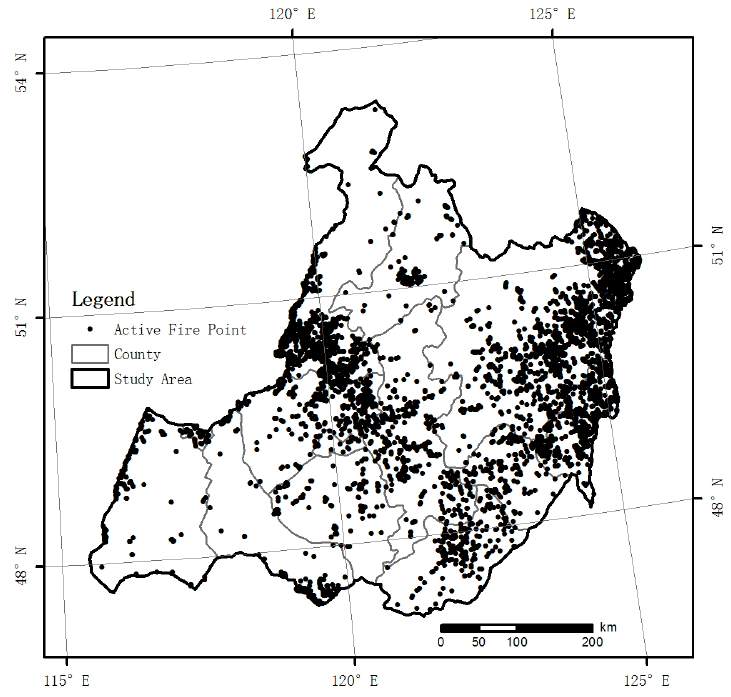
Figure 2. Distribution of grassland active fires in HulunBuir from 2000 to 2014. Table 2. Monthly occurrences of grassland active fire from 2000 to 2014.